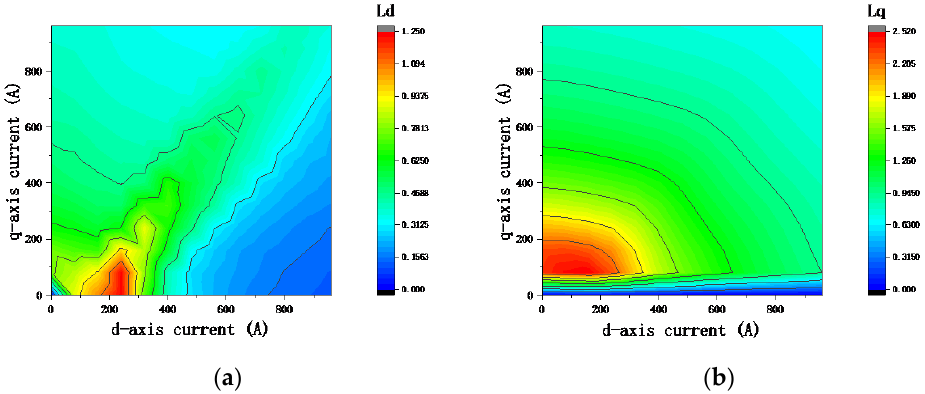
Figure A1. Dq-axis inductance contour map: ( a ) d-axis inductance; ( b ) q-axis inductance.